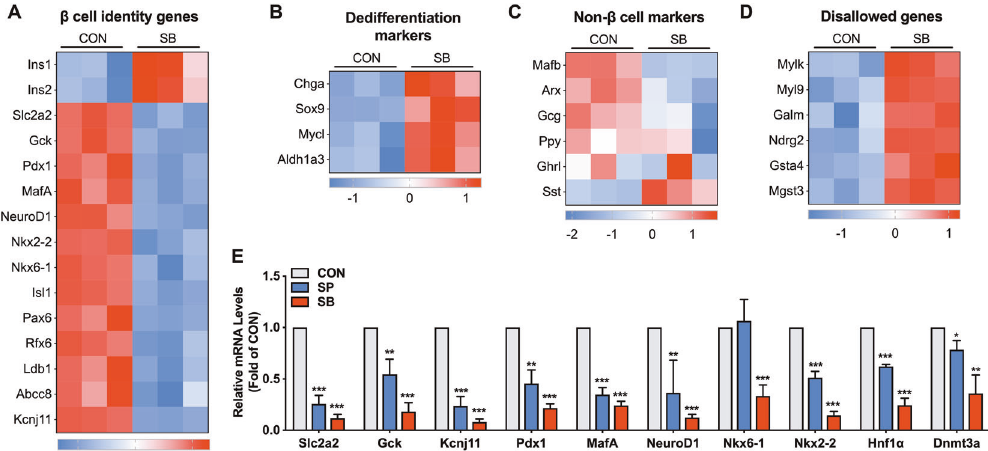
Fig. 2 Effects of sodium butyrate on the expression of β cell identity genes. A Heatmap of β cell identity genes in control and sodium butyrate (SB)-treated rat islets. B Heatmap of dedifferentiation markers. C Heatmap of non- β cell markers. D Heatmap of disallowed genes. E RT-qPCR analysis of β cell identity genes in rat islets incubated with 5 mM SP or 5 mM sodium propionate (SB) for 24 h. Data were given as mean ± SD for three separate experiments. * p < 0.05, ** p < 0.01, and *** p < 0.001 vs control (CON)